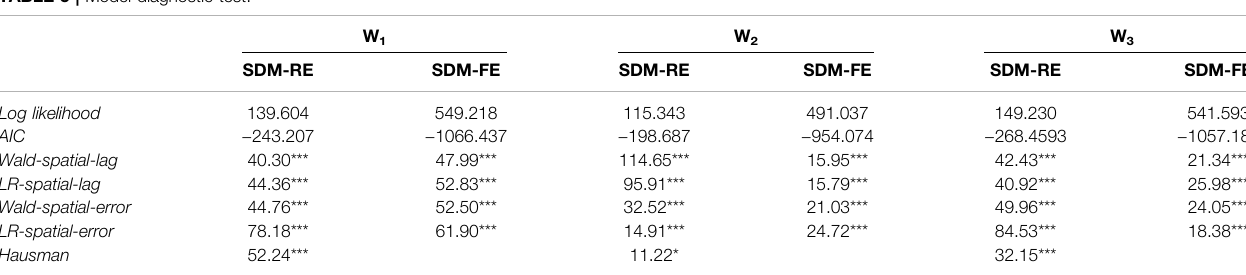
TABLE 5 | Model diagnostic